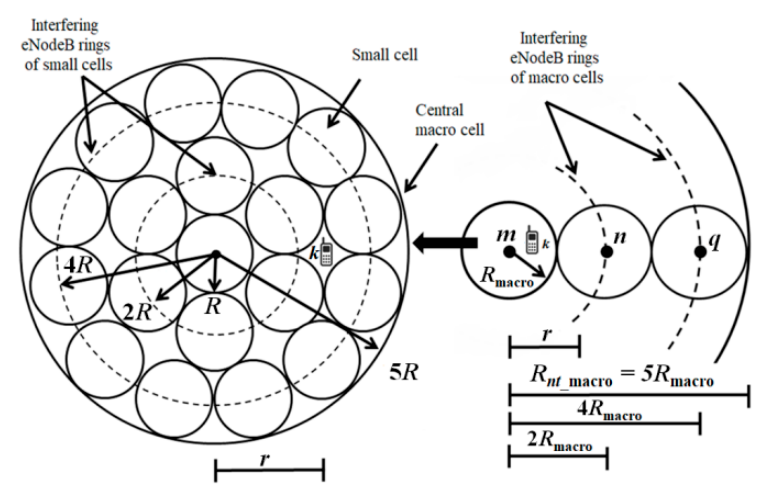
Figure 2. HetNet scenario for uniformly distributed small cells within a macro cell.